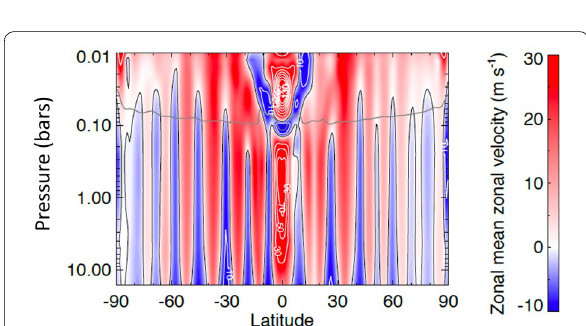
Fig. 6 Zonal mean zonal velocity cross-section, averaged over the final 100 days of a run using the Jason Jupiter model with semi-gray radiative transfer and moist convection active (assuming 4 × solar composition of H 2 O). White contours indicate zonal velocities in excess of 30 m s − 1 and the tropopause (where ∂ T /∂ p changes sign) is shown as a grey